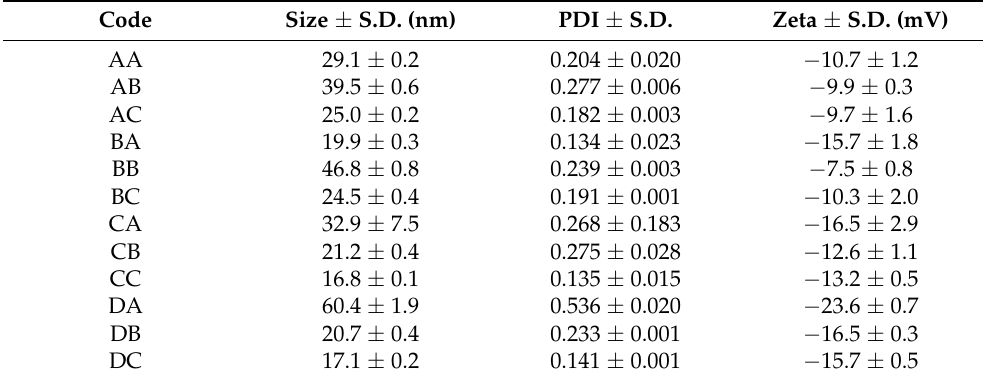
Table 2. Lipid nanoparticles ’ size (±S.D.), polydispersity index (PDI ± S.D.) and ζ potential (Zeta ± S.D.).